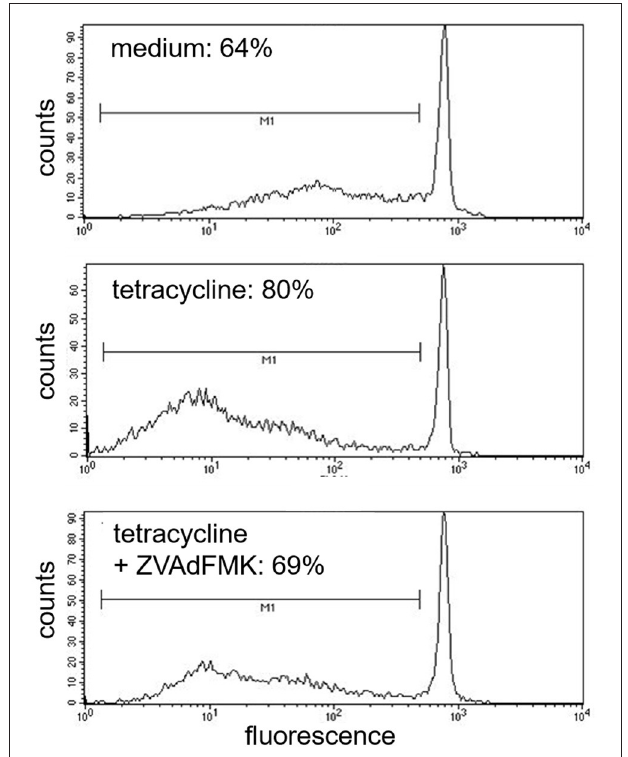
FIGURE 2 | Inhibition of tetracycline-induced apoptosis by pan-capase inhibitor (zVAD-fmk). Cells co-incubated for 48h with pan-caspase inhibitor (zVAD-fmk) and tetracycline (5 × 10 − 4 M) showed a similar amount of apoptotic nuclei (cells under the bar M1) like medium control (69%). One representative experiment out of five is